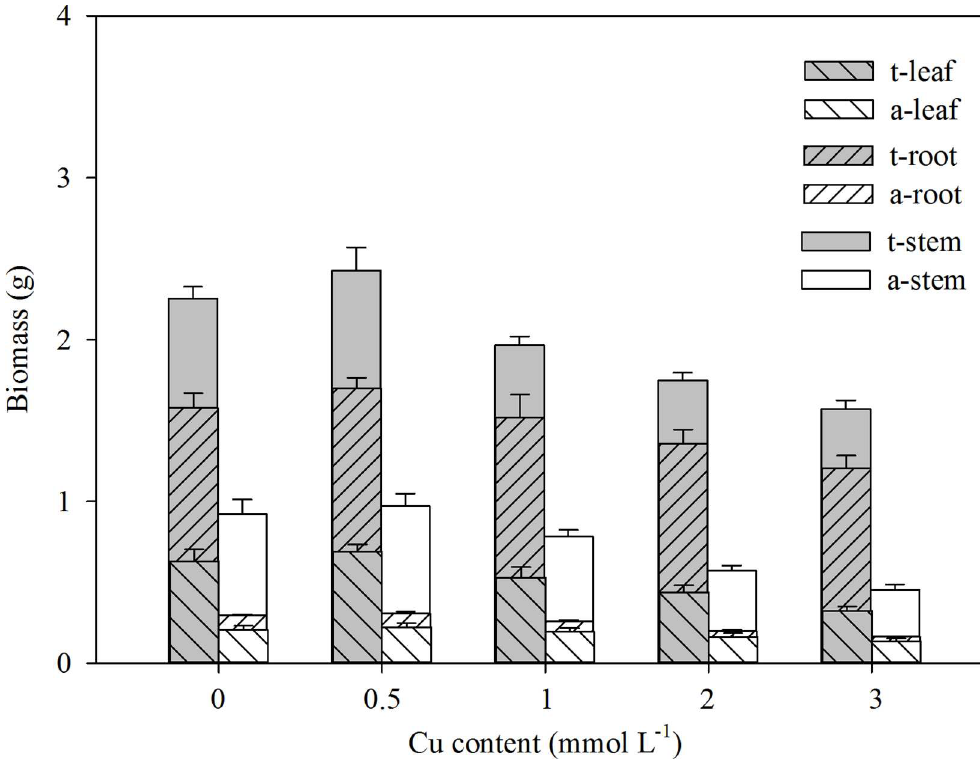
Fig 5. Leaf (right slash), root (left slash) and stem (blank) biomass of the plants in the terrestrial (gray bars) and aquatic habitats (white bars) under different Cu pollution conditions. Data are presented as the means ± SE without